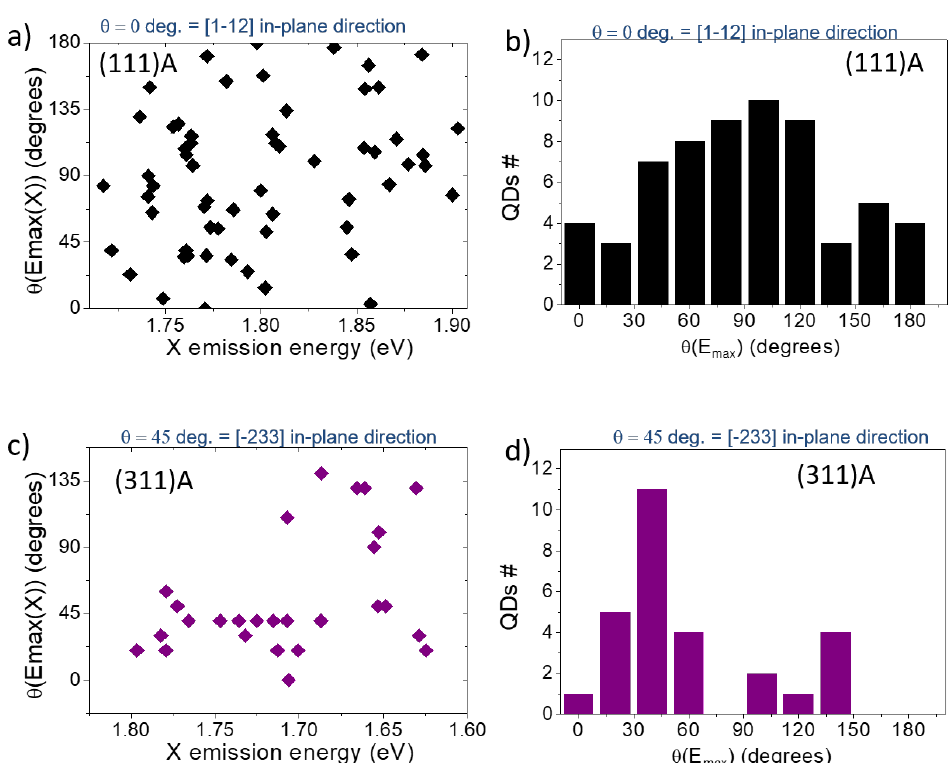
Figure 6. ( a ) Polarization angle θ ( E max ( X )) corresponding to the high energy split component of the X doublet for (111)A QDs as a function of the corresponding X emission energy obtained from a set of about 60 QDs. An angle of 0 degrees corresponds to the in-plane [1–12] direction. ( b ) Statistical distribution θ ( E max ( X )) for the (111)A QDs. ( c ) Polarization angle θ ( E max ( X )) corresponding to the high-energy split component of the X doublet for (311)A QDs as a function of the corresponding X emission energy obtained from a set of about 30 QDs. An angle of 45 degrees corresponds to the in-plane [ − 233] direction. ( d ) Statistical distribution of θ ( E max ( X )) for the (311)A